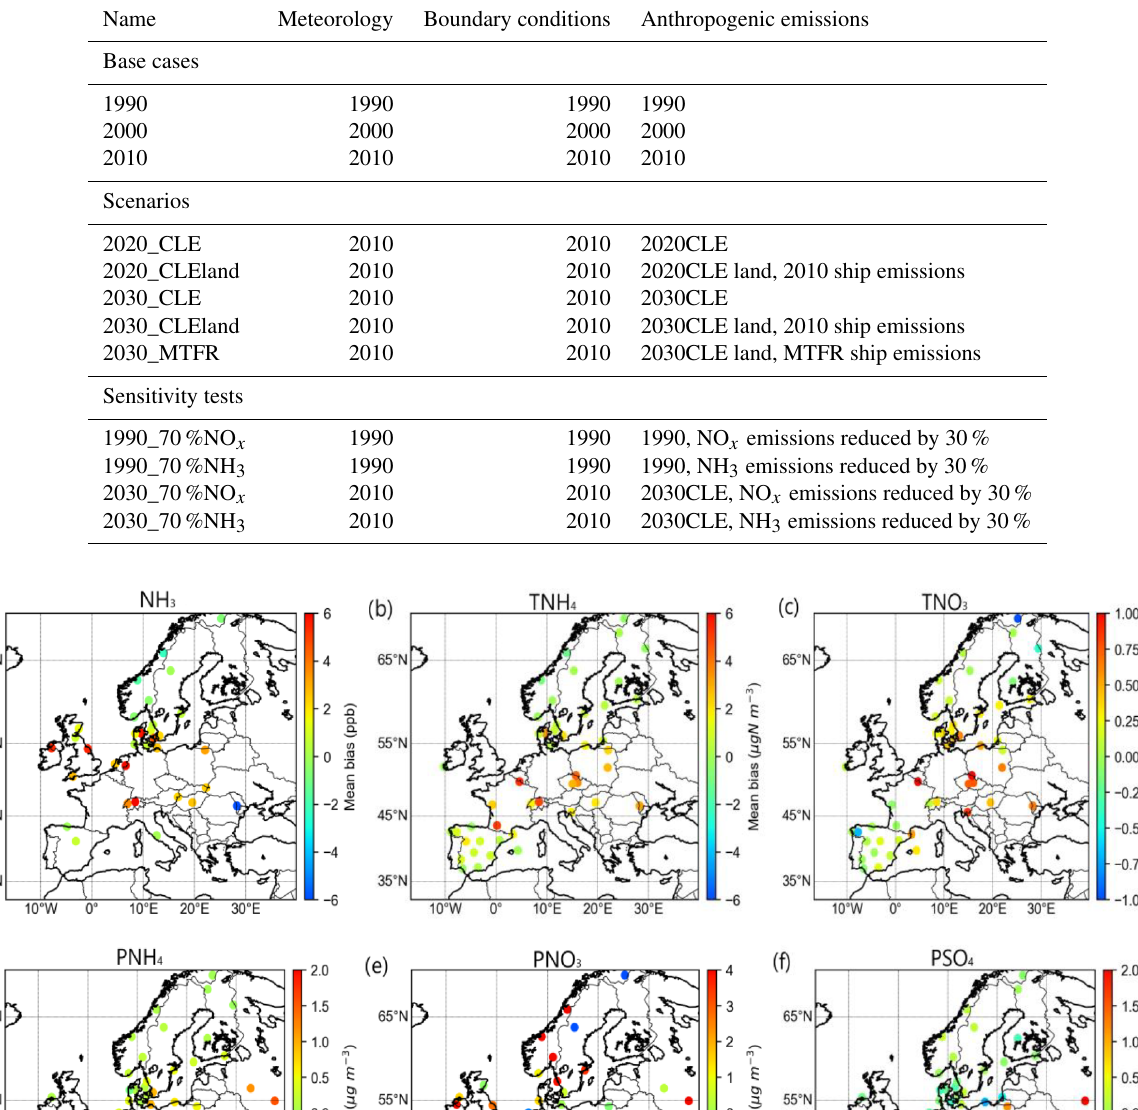
Table 1. Description of simulations. CLE: current legislation; MTFR: maximum technically feasible reductions.